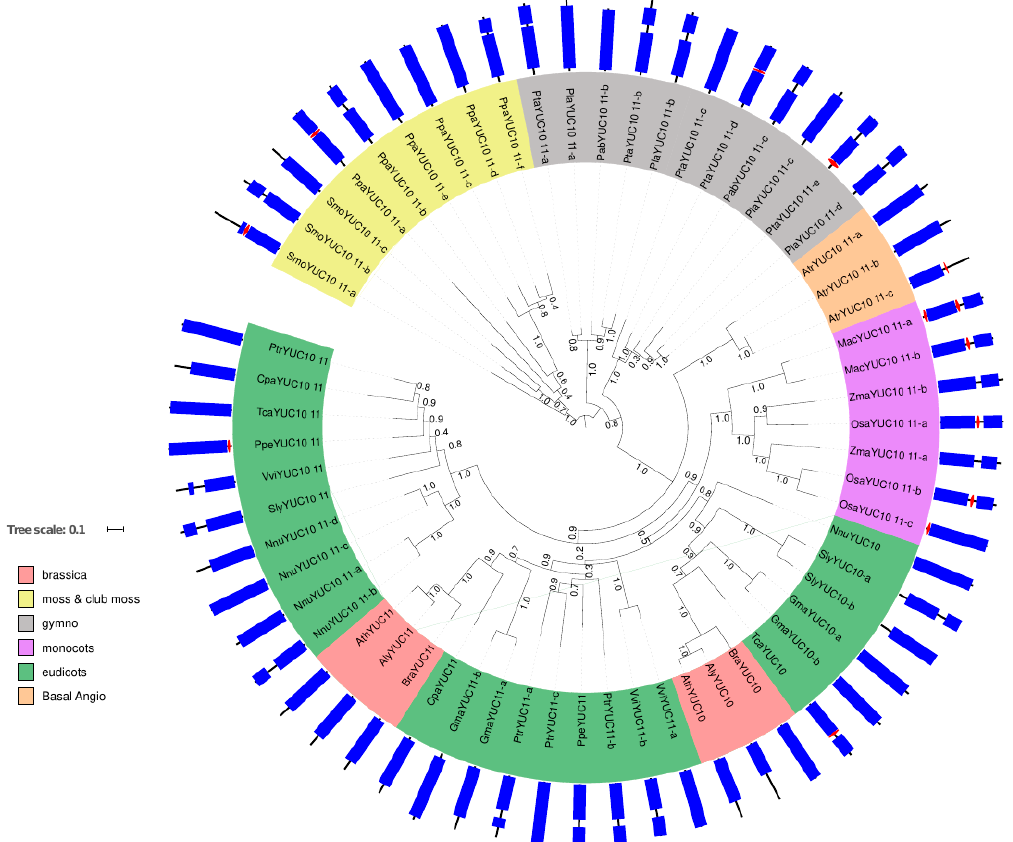
Figure 3. Phylogenetic tree of YUC10 and YUC11 homologous proteins. The tree is made using fast-tree with the maximum likelihood method [16] on YUC10 and YUC11 protein homologues constructed from an alignment using the MUSCLE alignment tool with default parameters [18]. Bootstrap values are indicated on the tree branches. Gene labels are constructed with the three letters from the species name (Table 1) and the gene name of the A. thaliana homologues (Table S1). The colour of the label shows the lineage of the plant. The corresponding protein domains (circle periphery) are obtained using InterProScan [15], red hexagons represent the TMD in the protein if applicable and blue rectangles indicate the flavin-dependent monooxygenase domain typical for YUC proteins.